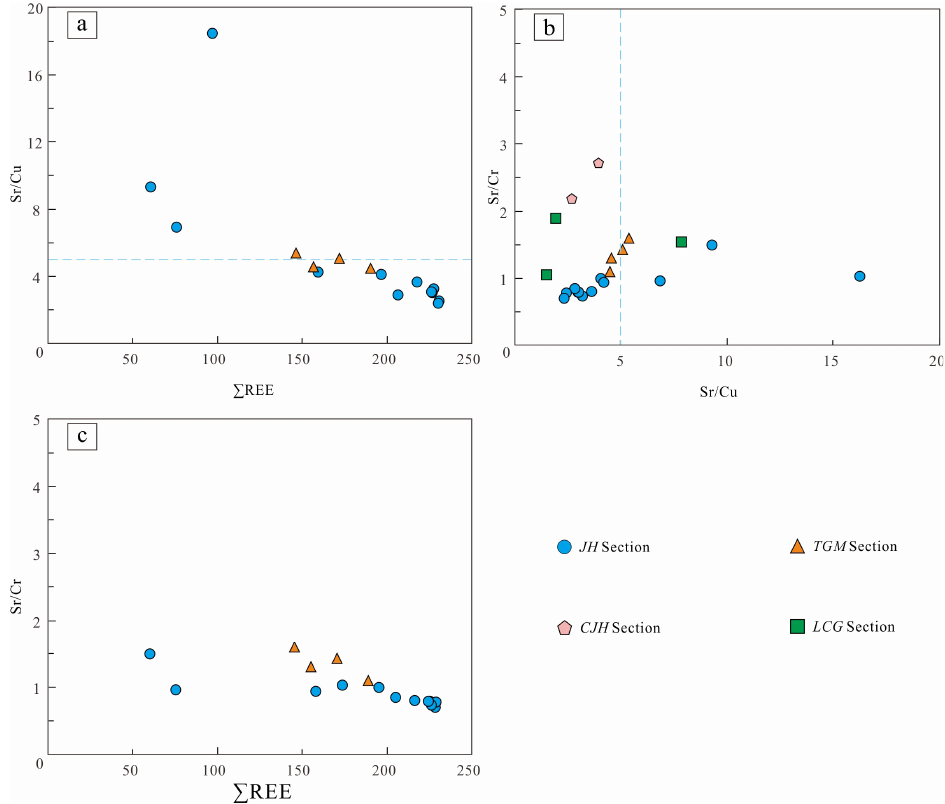
Figure 9. Diagrams of paleoclimatic and paleo-productivity changes in the Xu-3 Member. ( a ) Sr/Cu- REE correlation diagram; ( b ) Sr/Cr-REE correlation diagram; ( c ) Sr/Cu-Sr/Cr correlation diagram (CJH and LCG data from [32]).